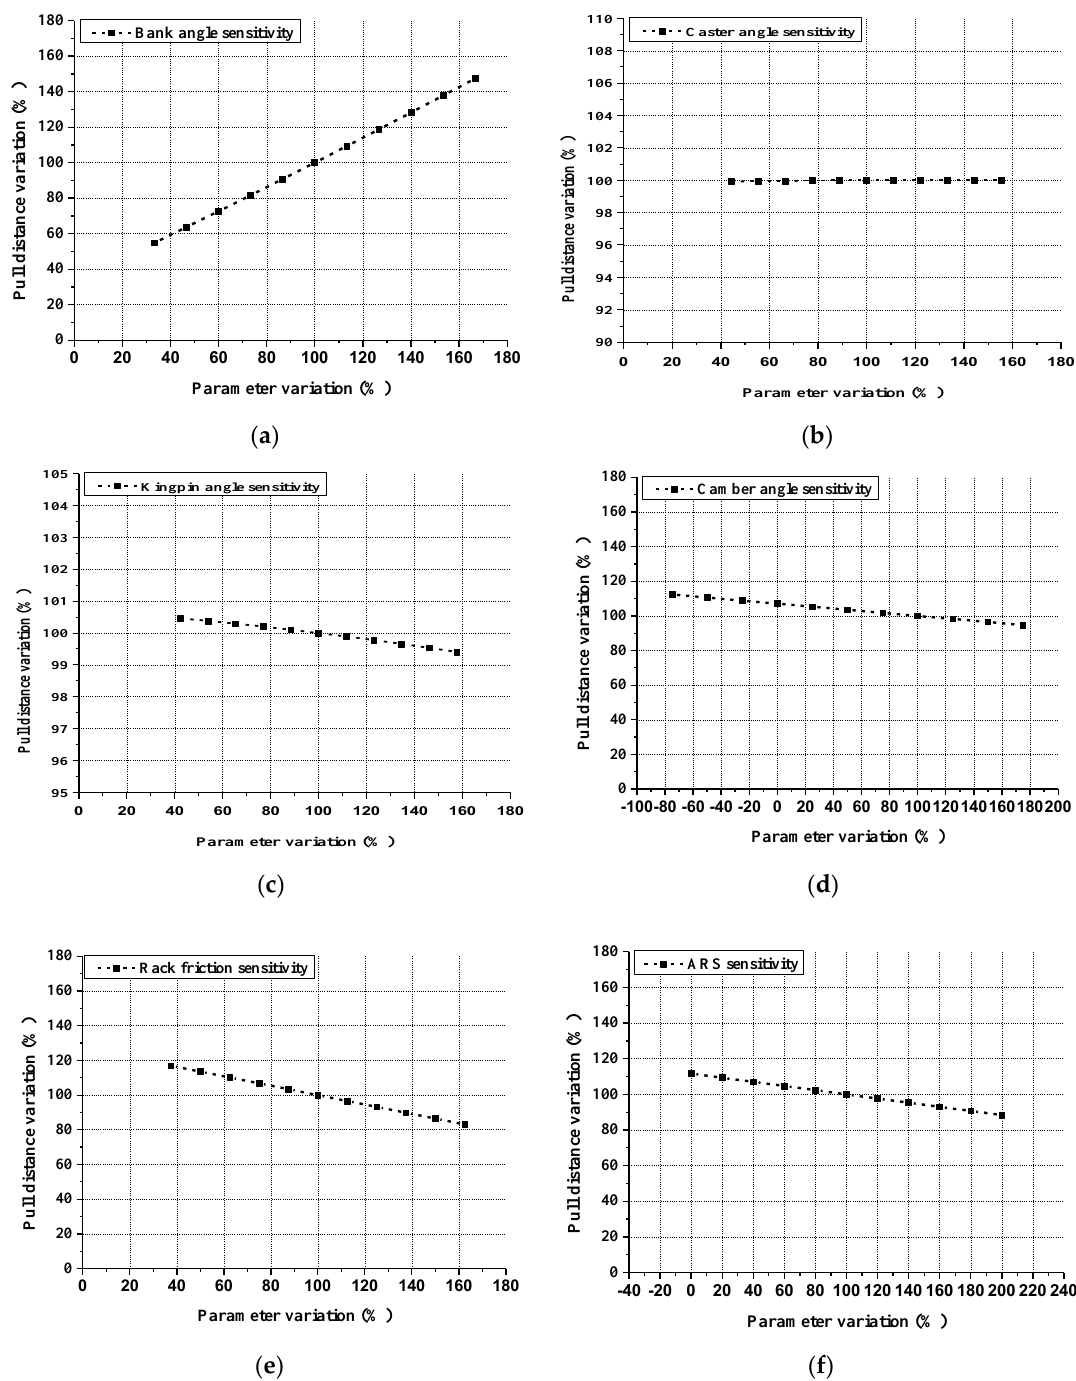
Figure 13. Sensitivity analysis ( a ) bank angle ( b ) caster angle ( c ) kingpin angle ( d ) camber angle ( e ) rack friction force ( f ) ARS stiffness.